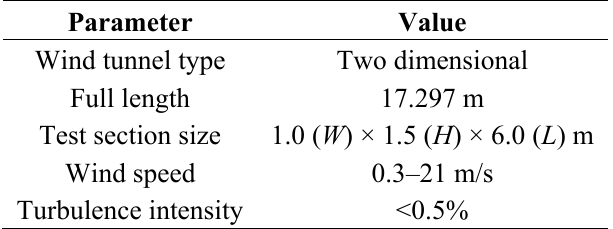
Table 5. Specifications of a small scale wind tunnel.